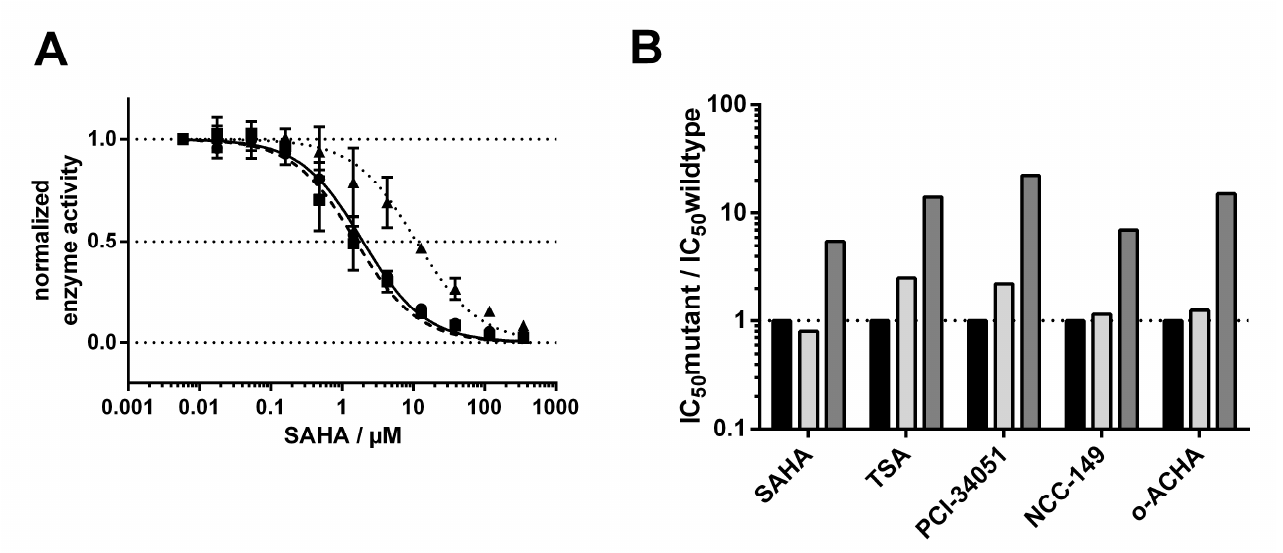
Figure 5. IC 50 determination and comparison. ( A ) Dose–response curve for the IC 50 determination of SAHA for HDAC8 wt ( ● , solid line), HDAC8 M274L ( ■, meshed line), and HDAC8 M274A ( ▲, dotted line). ( B ) Comparison of IC 50 values for different linear and L-shaped inhibitors for HDAC8 wt (black bar), HDAC8 M274L (light gray bar), and HDAC8 M274A (dark gray bar).